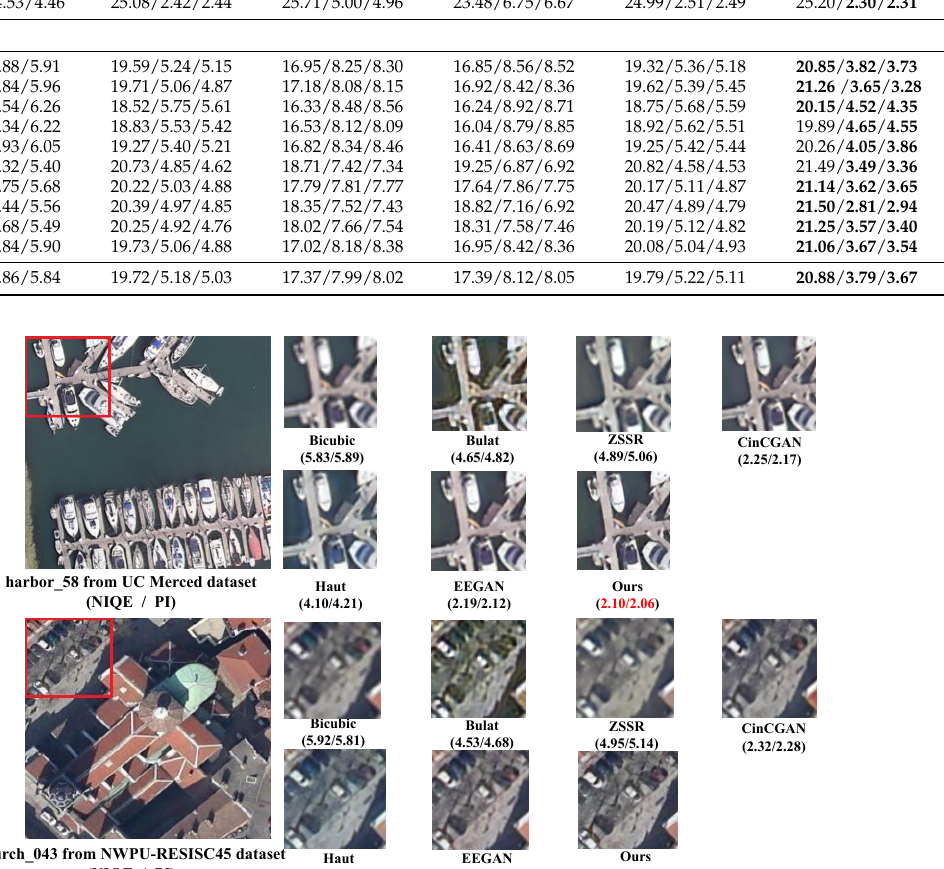
. For results × 200 pixels and 400 400. We crop the ROIs in × ×